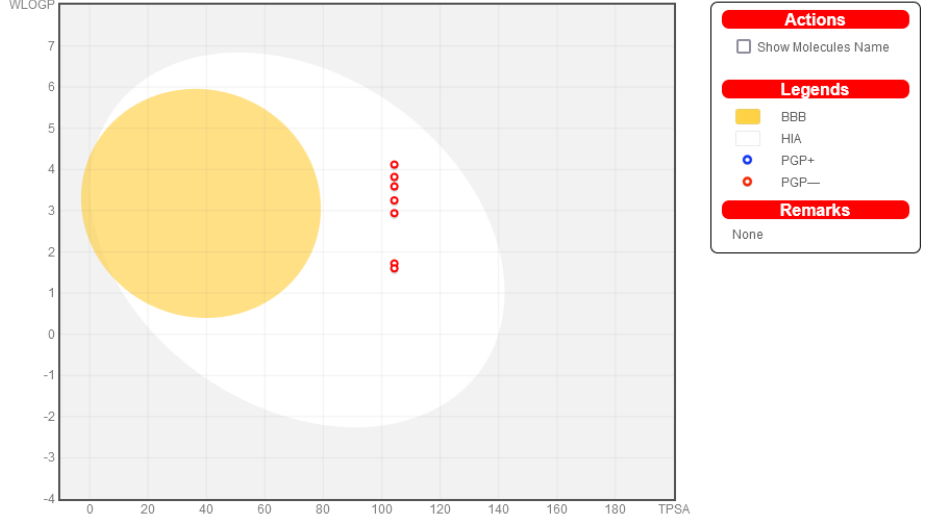
Figure 3. Predicted BOILED-egg model for compounds 6e , 8e , 6g , 9a – b , 9d , and 9g .